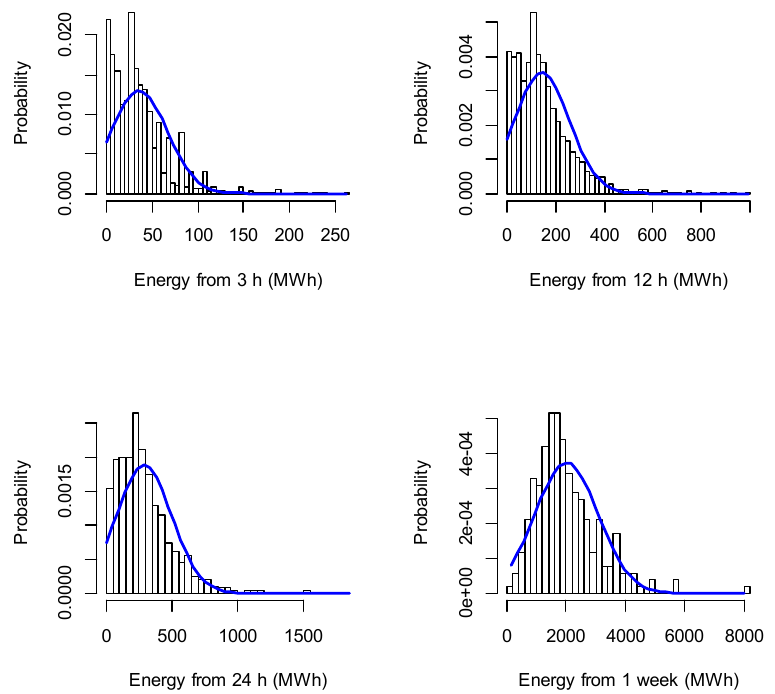
Figure 9. Histogram and pdf of a hybrid wind/wave system generated energy from 3 ‐ h to one ‐ week data.